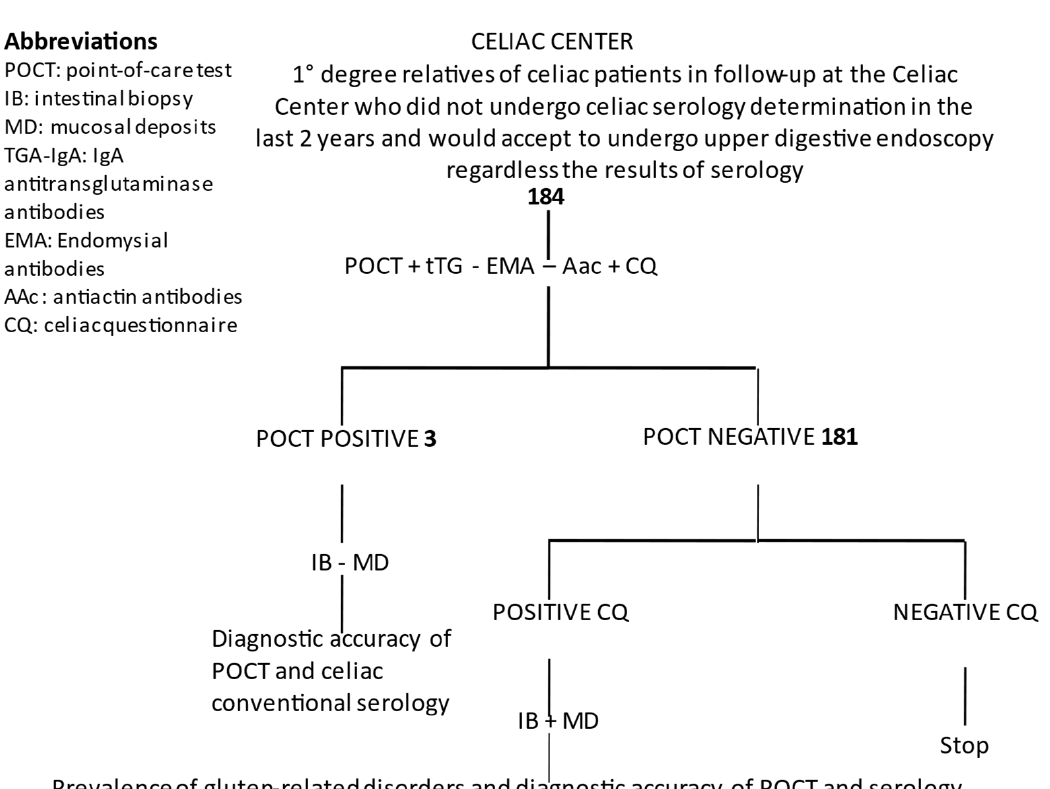
Figure 3. Study protocol in Sicily at the Celiac Center Setting, number of patients enrolled as of March 2022, and expected results.